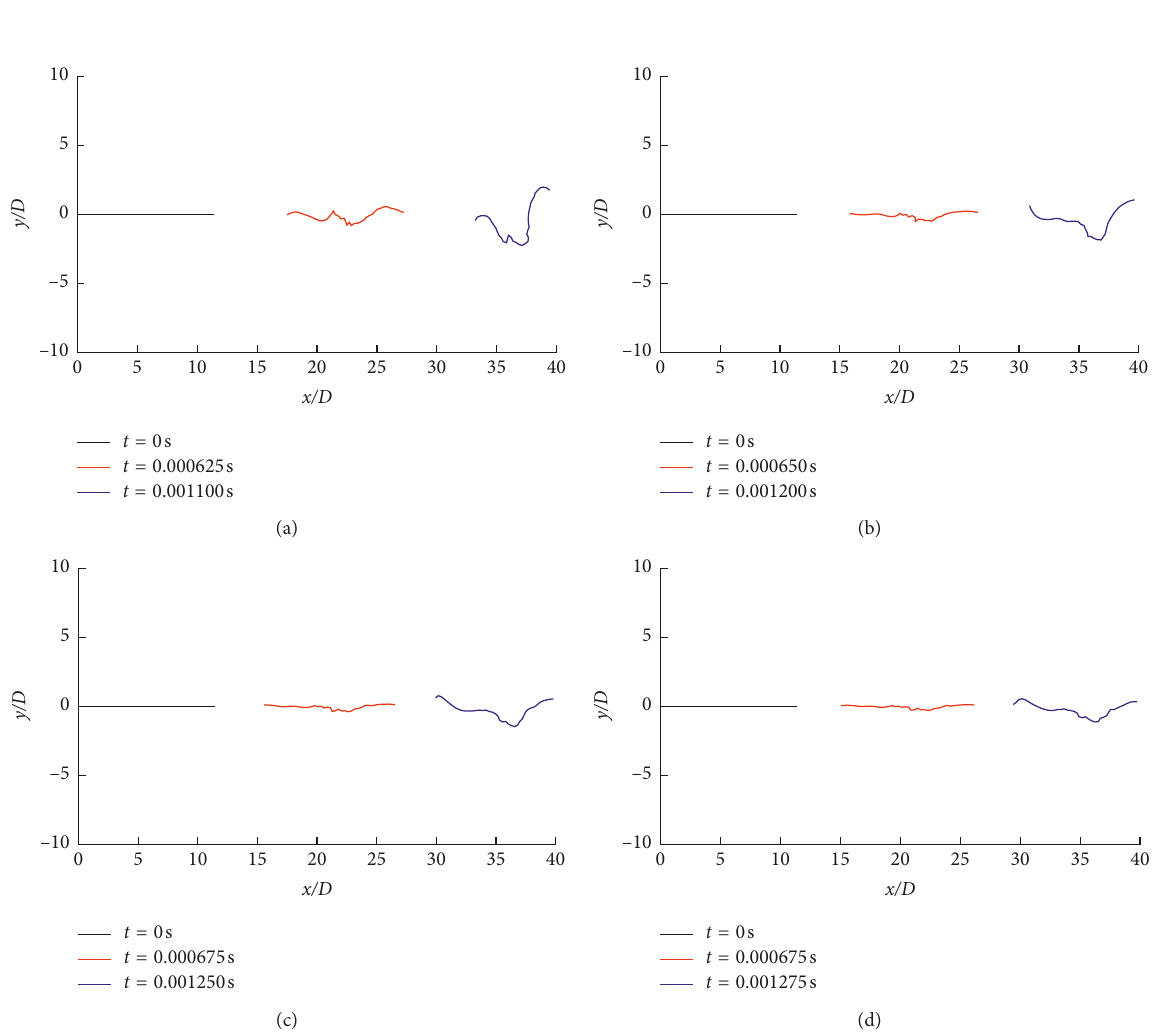
Figure 8: Motional characteristic of the fiber with different linear densities: (a) ρ